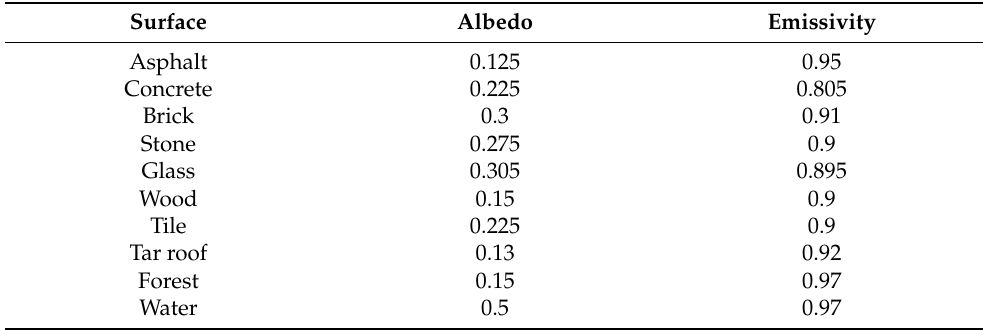
Figure 3. Pavement surface energy balance (Modified after Hu et al.) [61]. The porosity of permeable pavements typically ranges between 10% and 30%, while the saturated liquid permeability ranges between 5 × 10 − 5 and 4 × 10 − 3 s. The con- ventional dense pavement has porosity lower than 10%, and the liquid permeability is several orders of magnitude smaller [62]. Both higher porosity and higher permeabil- ity of the pavements enhance the evaporation rate and promote the evaporative cooling effect [63–65]. The transport of energy through the pavements related to radiation depends on albedo and emissivity. A part of solar radiation that reaches the pavement surface will be absorbed by the surface resulting in increased pavement thermal energy. The absorption rate per unit surface area ranges from zero to one, where zero indicates no energy absorption by the surface [60]. An indicator of the energy reflected by the surface called albedo is measured on a scale from zero to one, where zero indicates that the surface absorbs all solar radiation and one that total solar radiation is reflected [64]. The albedo tends to change over time due to the ageing of the material, weathering, and dirt accumulation [65]. A part of the absorbed energy is stored within the pavement and emitted continuously into the atmosphere. The energy emitted per unit surface area is called emissive power. Emissivity refers to the ratio of energy radiated by the surface compared to the radiation emitted by a black body at the same temperature and determines the contribution of material to the UHI [60,64,65]. Table 3 shows typical values of albedo and emissivity for a variety of urban surfaces. Table 3. Typical values for emissivity and albedo (Modified after Bradley et al.) [66]. Surface Albedo Emissivity Asphalt